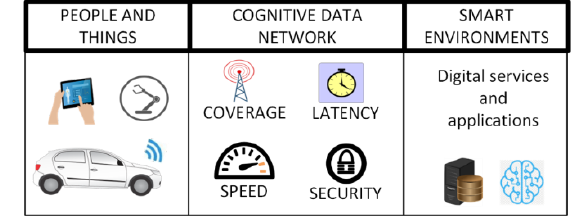
Figure 1. Connected environments through cognitive data networks.